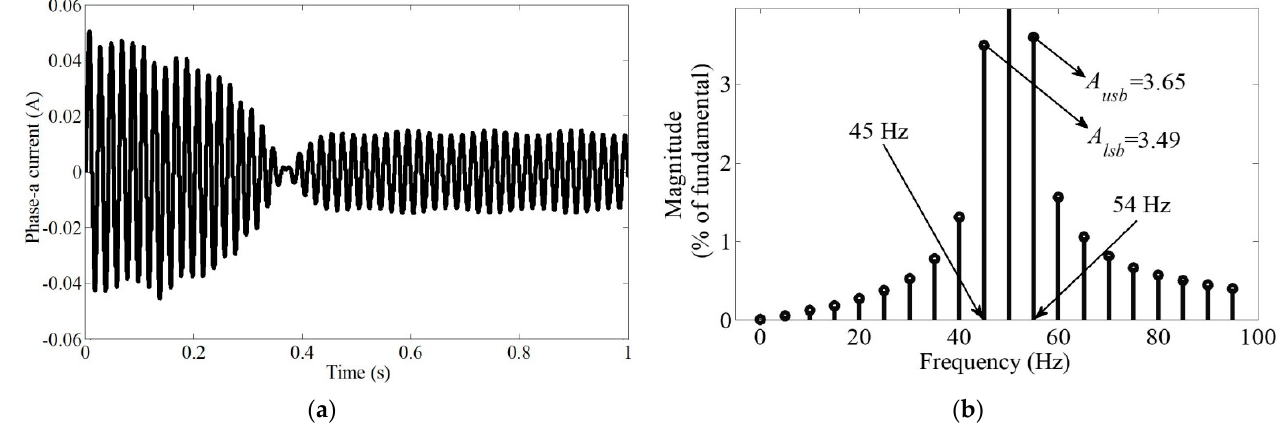
Figure 2. Analysis of rotor bar crack fault of a 5.5 kW SCIM (1 faulty bar) in stationary regime: ( a ) Phase-a current ( i a ) with 50 Hz frequency, and ( b ) FFT spectrum of stationary i a .